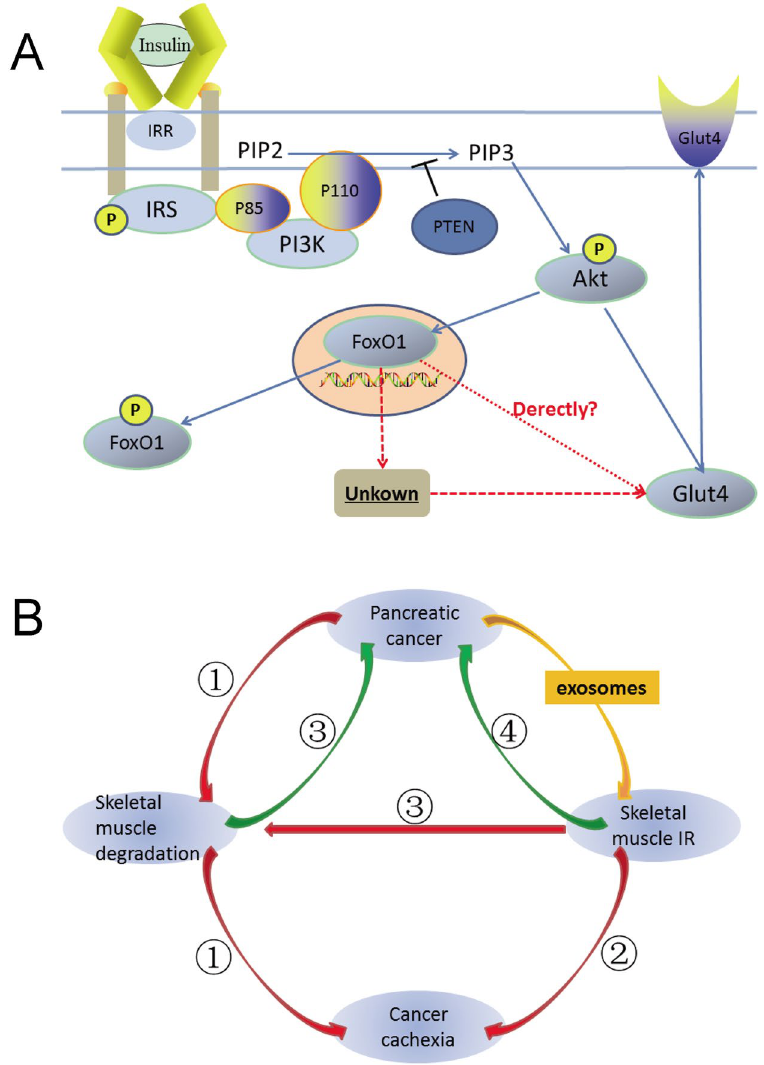
Figure 8. Schematic of the mechanism and magnificent background involved in this study. ( A ) Schematic of the insulin and PI3K/Akt signalling pathways. Dashed lines indicate a possible mechanism. ( B ) Schematic of the metabolic crosstalk between PC and skeletal muscle: ① UPS plays a key role in cancer patients’ experience of skeletal muscle loss; ① A close connection between the degree of severity of IR and progression of cancer cachexia; ① IR exacerbates skeletal muscle degradation as cancer evolves, which produces amino acids for tumour proliferation; ① Under the conditions of IR, overexpression of IRR and IGF-1 receptor in tumour cells promotes tumour